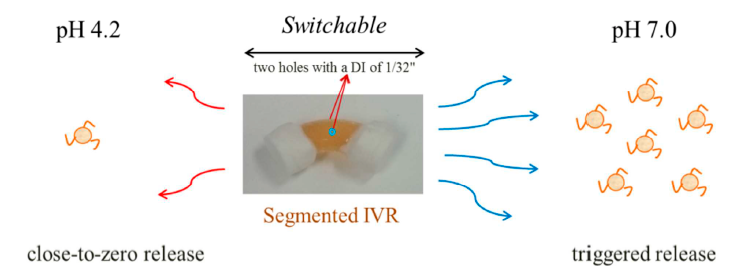
Figure 7. Diagram of pH-responsive supramolecular polyurethane (PU) hydrogel in reservoir-segmented intravaginal ring (IVR). The fabrication process of segmented IVR are as follows: (1) The reservoir of IVR are filled with PU hydrogel. (2) The ends are capped with custom-fabricated plastic lids and sealed with polymer resin. (3) Two holes are made for the switchable on-demand release of siRNA-loaded nanoparticles. Reproduced with permission from “Switchable On-Demand Release of a Nanocarrier from a Segmented Reservoir Type Intravaginal Ring Filled with a pH-Responsive Supramolecular Polyurethane Hydrogel” by Kim et al. [124].